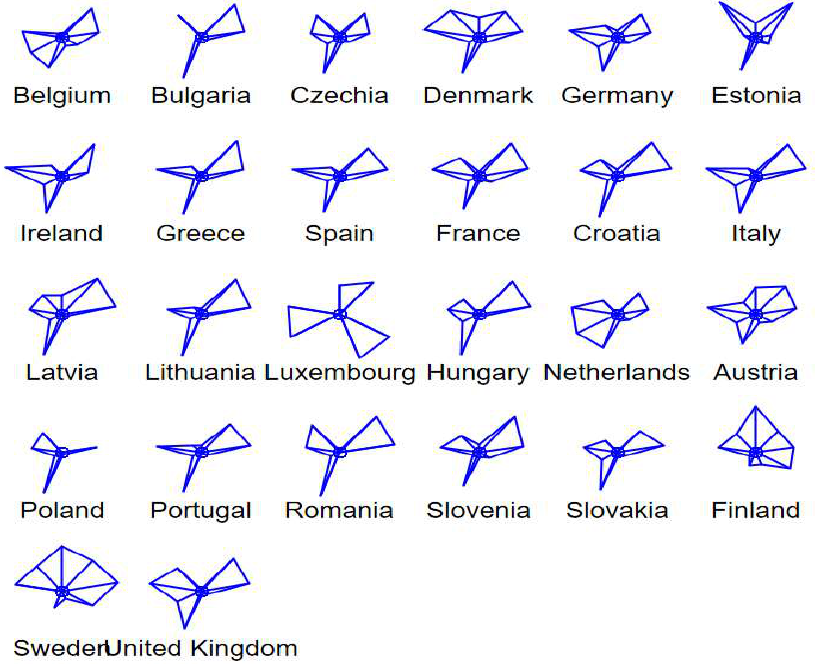
Figure 2. Star-type chart for EU countries accessed according to nine diagnostic variables for 2018. Source (own elaboration).